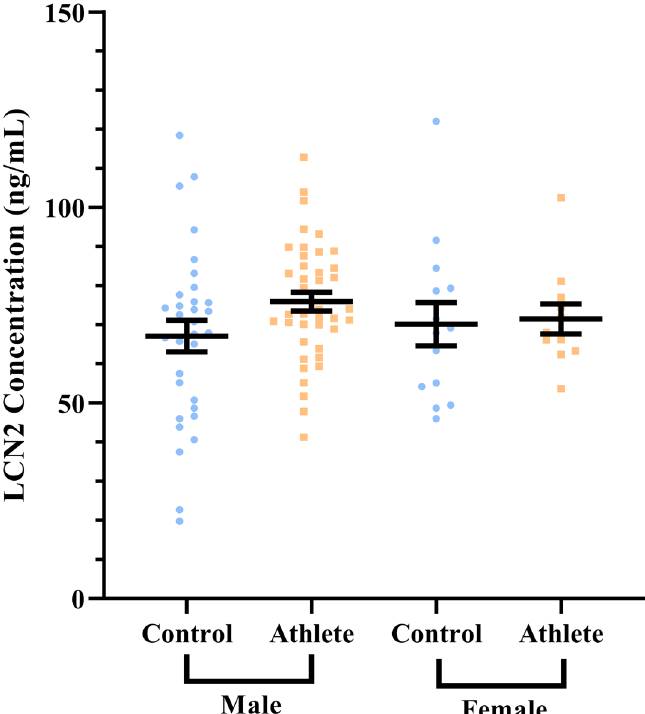
Figure 2. There was no significant difference in plasma lipocalin-2 (LCN2) protein levels between male controls (n = 34) and endurance athletes (n = 41) ( P = 0.053), or between female controls (n = 14) and endurance athletes (n = 11) ( P = 0.847). Data are expressed as mean ± S.E.M. from two-tailed Man-Whitney U-test.